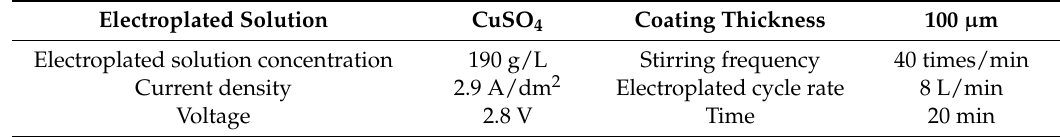
Table 4. Parameters of the electroplated Cu